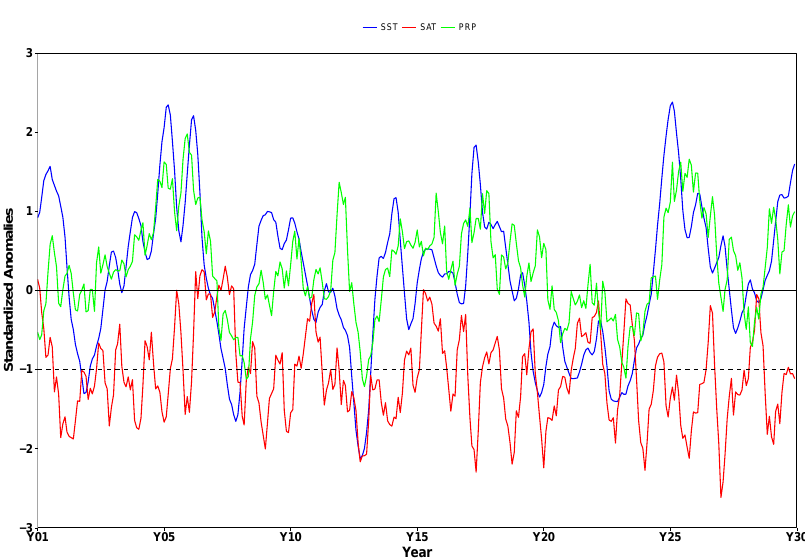
Figure 5. Time evolution of the standardized anomalies of surface air temperature (SAT) in the RRM region ( red line ), the sea surface temperature (SST) in the Ni no3.4 region (5 ◦ S to 5 ◦ N, 120 ◦ W to 170 ◦ W, blue line ) and total precipitation in the east Pacific region (0 ◦ S to − 10 ◦ S, 148 ◦ E to 180 ◦ E, green line ). The standardized anomalies are averaged for the respective regions. The dashed line shows the SAT at − 1.0 in the RRM region, which differentiates the strong and weak cooling scenarios. Graf and Davide (2012) [79] demonstrated teleconnections between El Ni no and Atlantic/European regional climates, which involve a dynamic coupling of the troposphere with the stratosphere. A similar coupling mechanism is also noticeable when assessing the position of the sub-tropical jet streams in the two simulations (Figure 6). Situations with relatively limited RRM local cooling show little change in the position of the jet (Figure 6a). However, intense local SAT change is correlated with a shift of the jet core towards the Equator over the north Pacific (Figure 6a). This dynamical coupling mechanism can be further explained by upper tropospheric circulations (Figure A5a,b). In the Northern Hemisphere mid-latitudes, the stream function anomalies are similar to the geopotential height anomalies in terms of their pattern, with anti-cyclonic and cyclonic circulation anomalies in the positive and negative stream function positions,